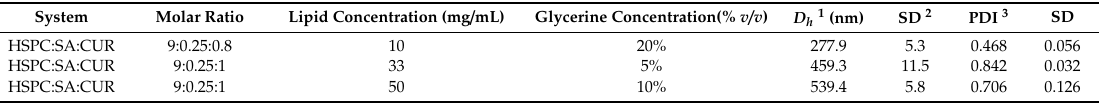
Table 2. The physicochemical properties of reconstituted lipidic vehicles HSPC:SA 9:0.25 with glycerine concentration 20% and 15% v/v after lyophilization and reconstitution. Table 3. The physicochemical properties of lipidic vehicles with incorporated curcumin developed through the present